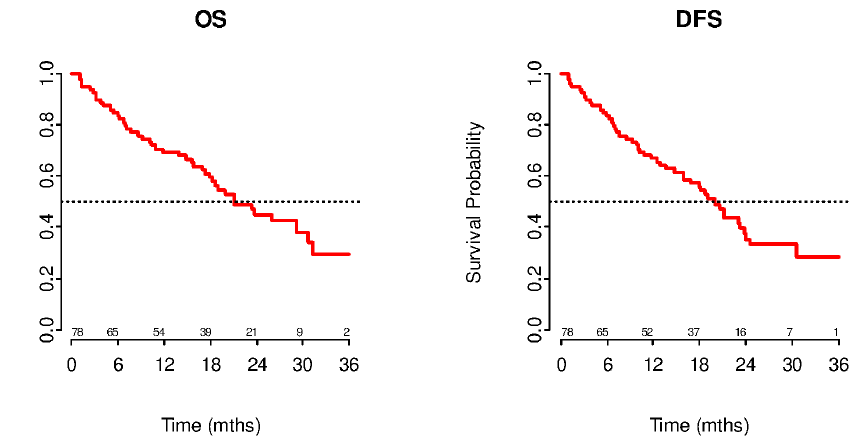
Figure 1. Kaplan Meijer curves present the survival probability for overall survival and disease free survival respectively.